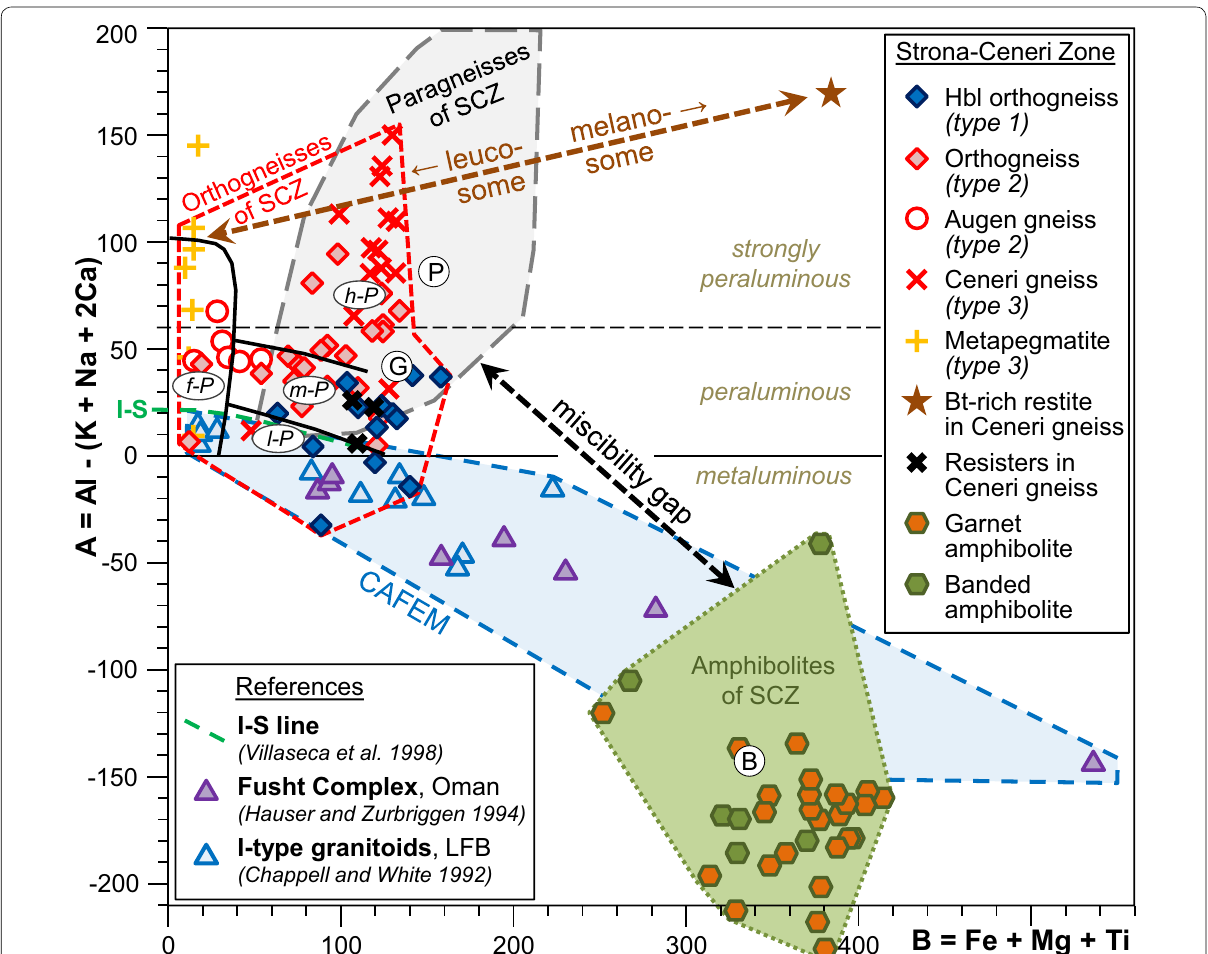
Fig. 7 A-B diagram after Debon and Le Fort (1988) for orthogneisses and paragneisses (data from Zurbriggen et al. 1997), garnet amphibolites (data from Buletti 1983) and dark layers of banded amphibolites (data from Pinarelli et al. 2008) of the Southern Alpine Strona-Ceneri Zone (SCZ). Data of I-type granitoids from the Lachlan Fold Belt (LFB, Australia) and the tonalitic Fusht Complex (southern Oman) are from Chappell and White (1992) and Hauser and Zurbriggen (1994), respectively. Mean compositions of pelites or shales (P) and greywackes (G) are from Pettijohn (1963), and mean composition of common basalts (B) is from Le Maitre (1976). I-S line and fields for h-P (highly peraluminous), m-P (moderately peraluminous), l-P (low peraluminous) and f-P (felsic peraluminous) are drawn according to Villaseca et al. (1998). For explanations see